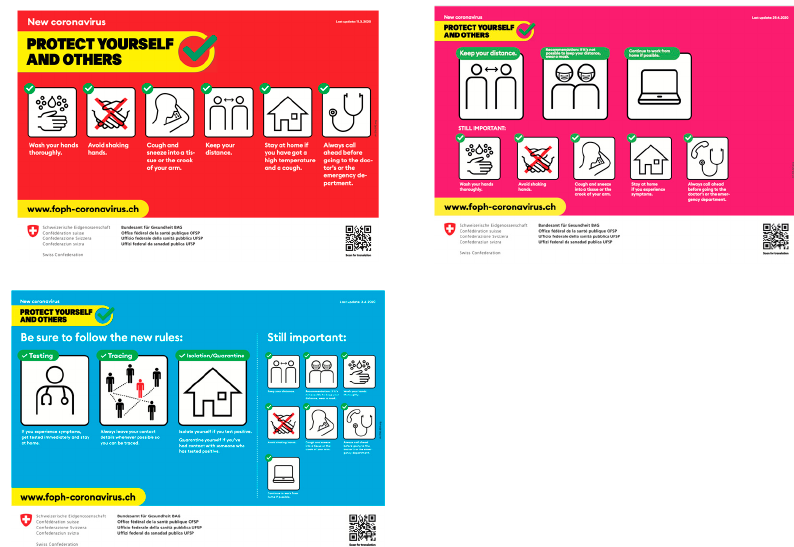
Figure 5. Federal Office of Public Health ( FOPH) image campaign “Protect yourself and others;” Figure 5. Federal O ffi ce of Public Health (FOPH) image campaign “Protect yourself and others;” available online